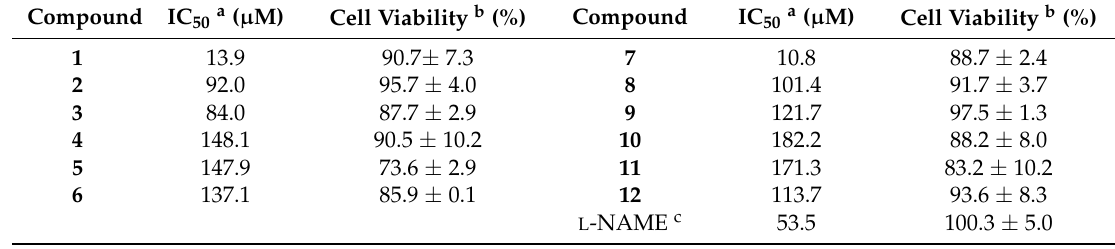
Table 2. Inhibitory activity of compounds 1 – 12 on NO production in LPS-activated BV-2